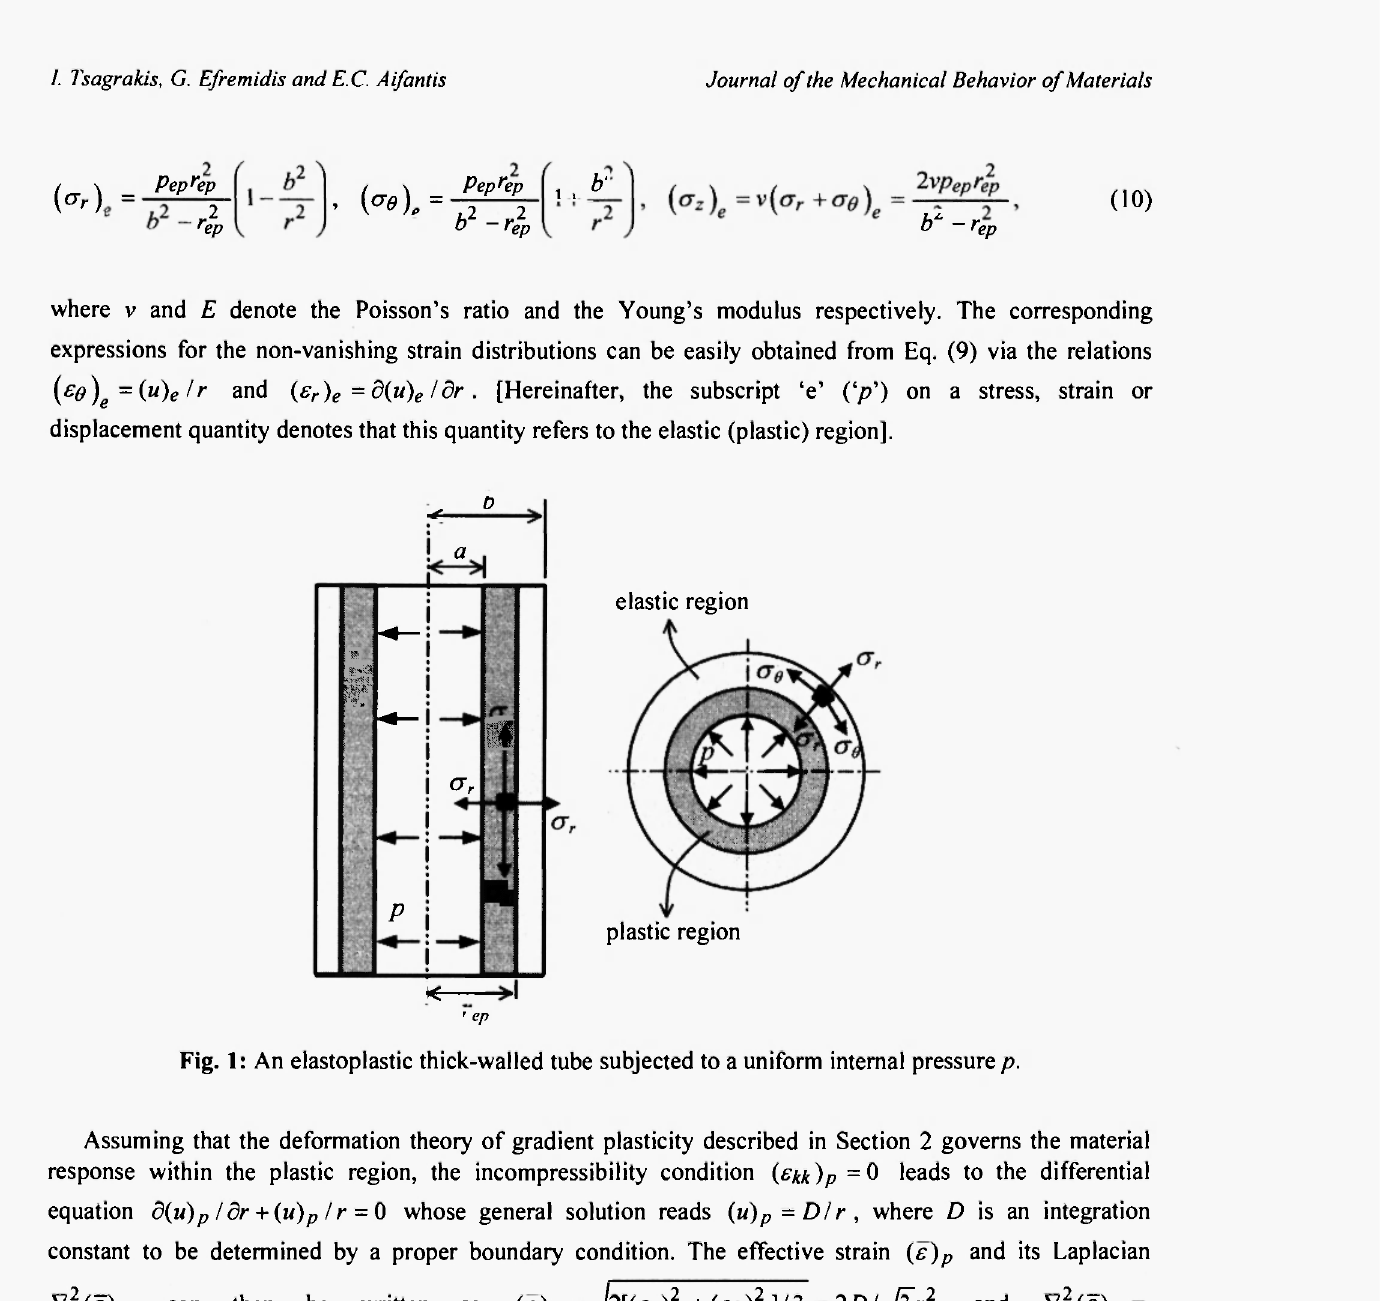
Fig. 1: An elastoplastic thick-walled tube subjected to a uniform internal pressure